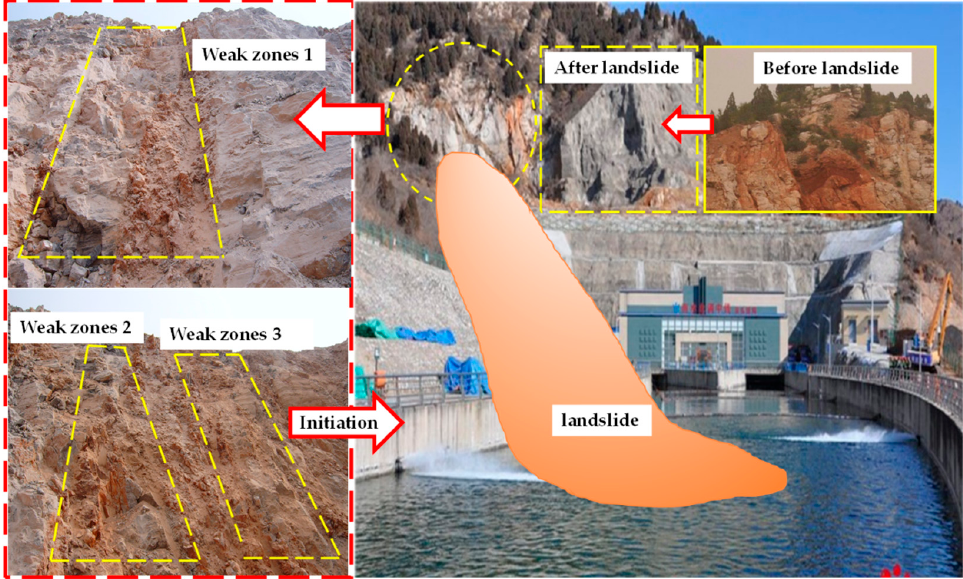
Figure 11. Typical failure mode of Gangtou tunnel slope engineering (the rock in the slope is weathered flint-striped dolomite, and the soil in the weak zones is residual cohesive soil). To illustrate the influence of the rotation angle of the layer of weak zones inside the slope on the stability and failure mechanism of the slope, weak zones with a rotation of 0–60° relative to the X -axis, Y -axis and Z -axis were generated in the 3D slope. The model was about 34 m long, 33 m high and 49 m wide. The number of finite element mesh elements was 399,611 and the number of nodes was 73669. The constraint boundaries around the model were normal bearing constraints, and the bottom of the slope was a complete constraint condition as is shown in Figure 12. Both weak zones and weathered flint strips dolomite are elastoplastic materials, and the Mohr-Coulomb yield criterion was adopted. The rock in the slope shown in Figure 11 is weathered flint-striped dolomite, and the soil in the weak zones is residual cohesive soil. The parameters are shown in Table 3.